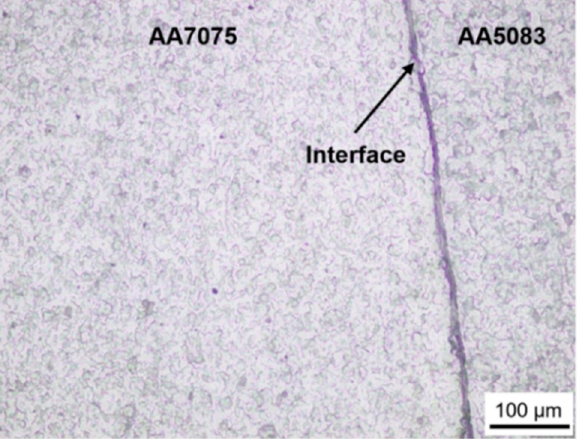
Figure 10. An example of DRZ microstructure near the interface produced at the rotational speed of 1200 rpm.